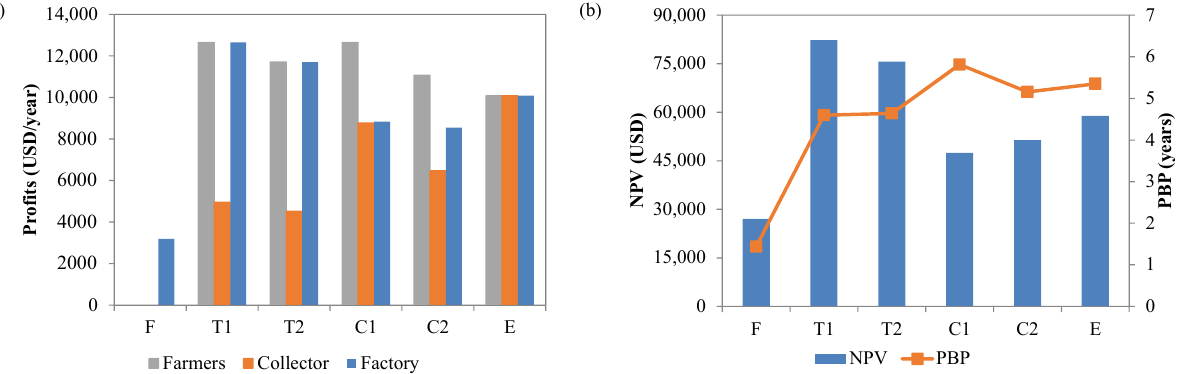
Figure 5. ( a ) Profits of all stakeholders and ( b ) economic performance obtained from different scenarios. Figure 5. ( a ) Pro fi ts of all stakeholders and ( b ) economic performance obtained from di ff erent sce- narios.